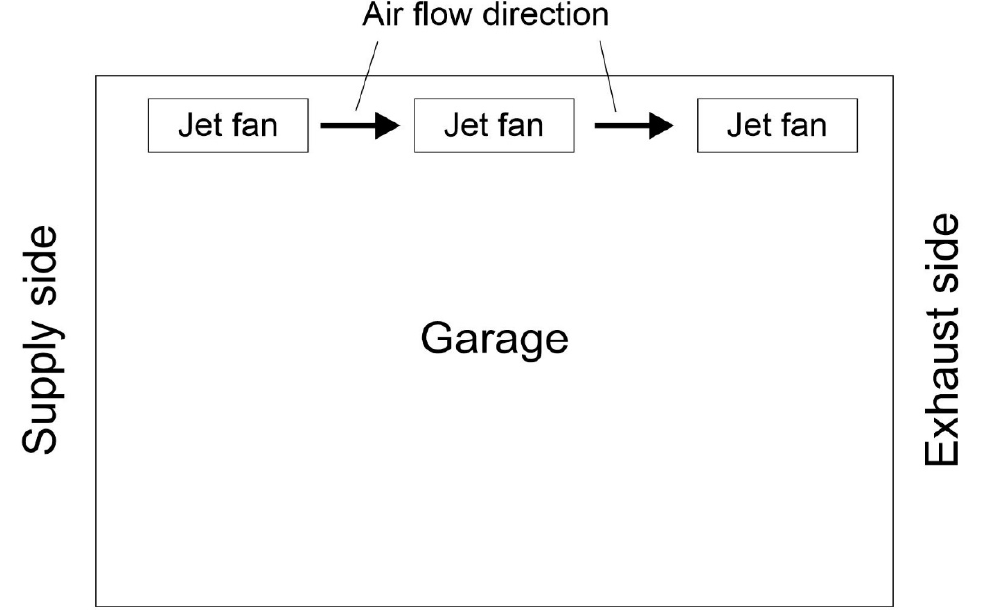
Figure 2. The scheme of applied jet ventilation.